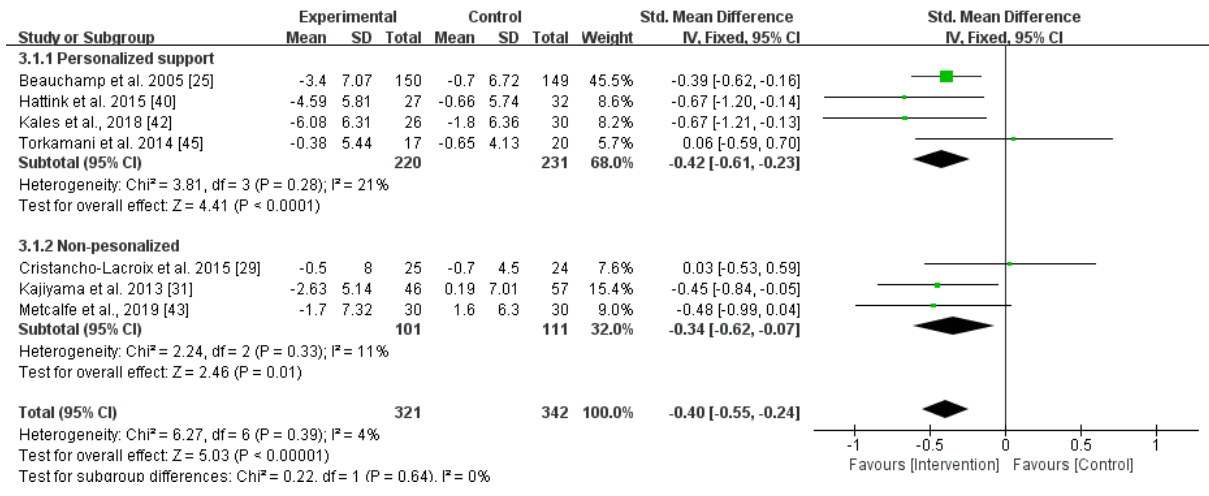
Figure 5. The effect of internet-based supportive interventions on perceived